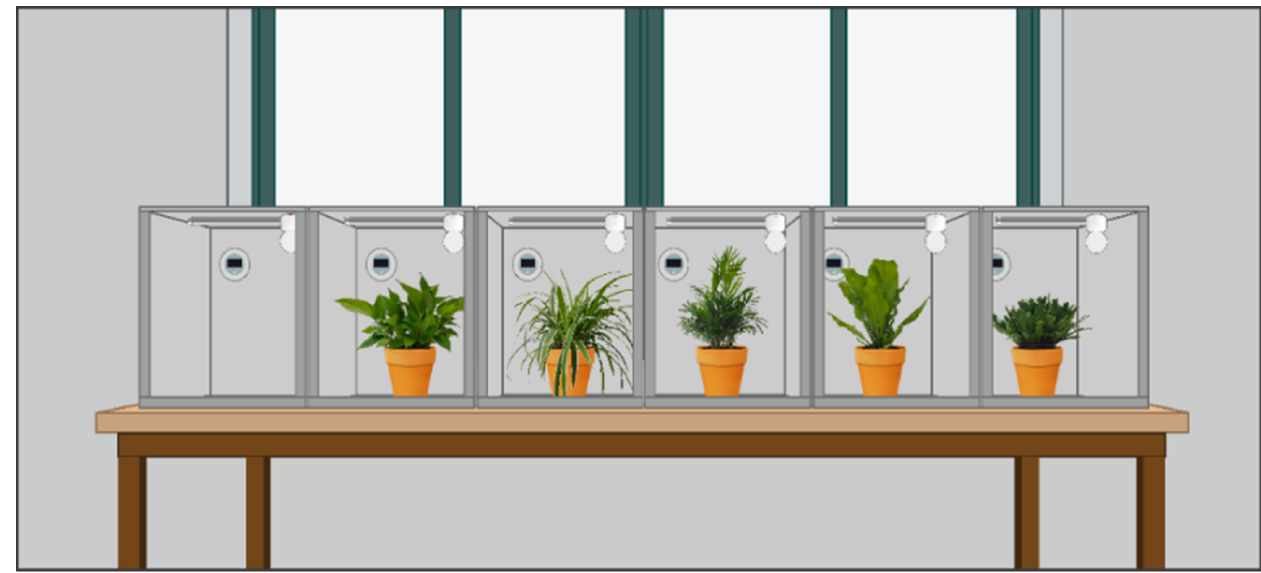
Figure 2. Experimental site layout.